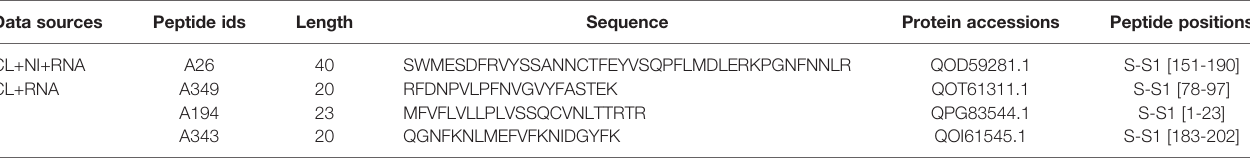
CL, Cell-line infected proteome; NI, Natural infected human patients; RNA, Transcriptome; S,